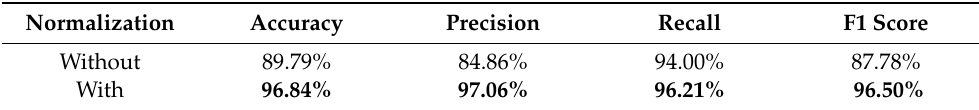
Table 2. The influence of normalization on